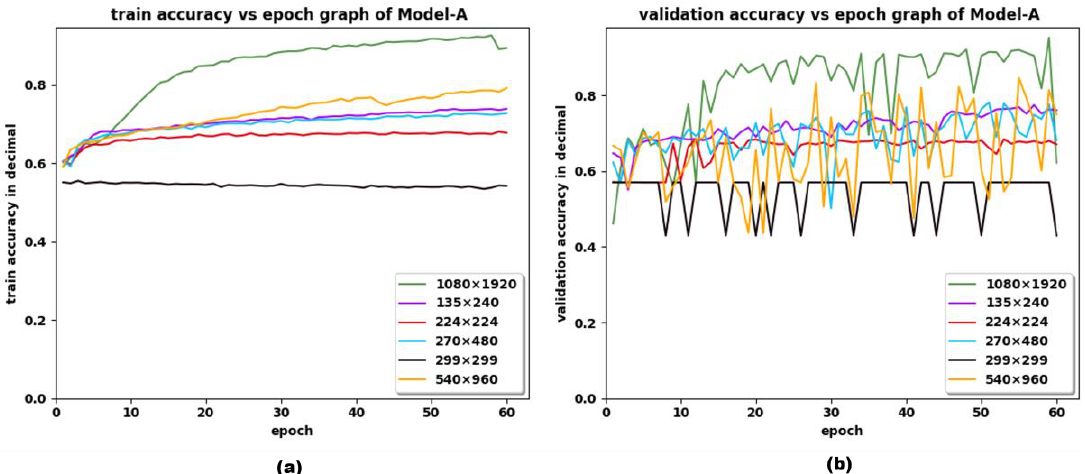
Figure A1. Comparison of ( a ) train and ( b ) validation accuracy versus epoch obtained with various